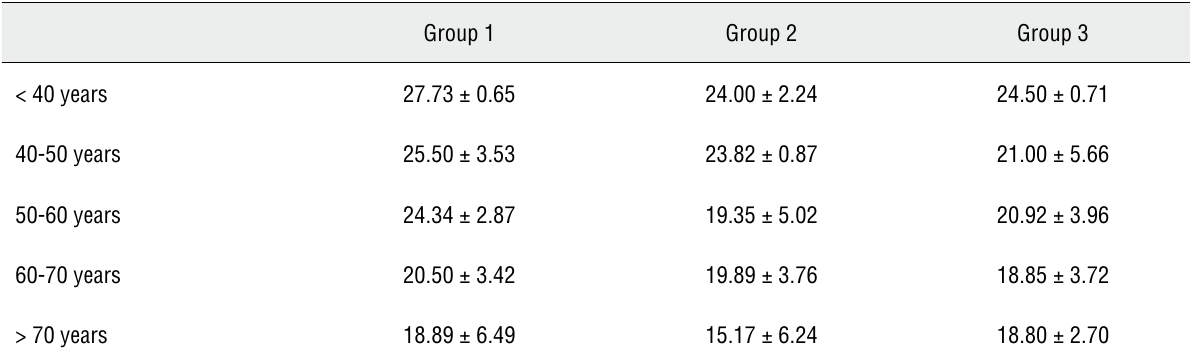
Table 4 - IIEF scores relative to age groups and number of occluded